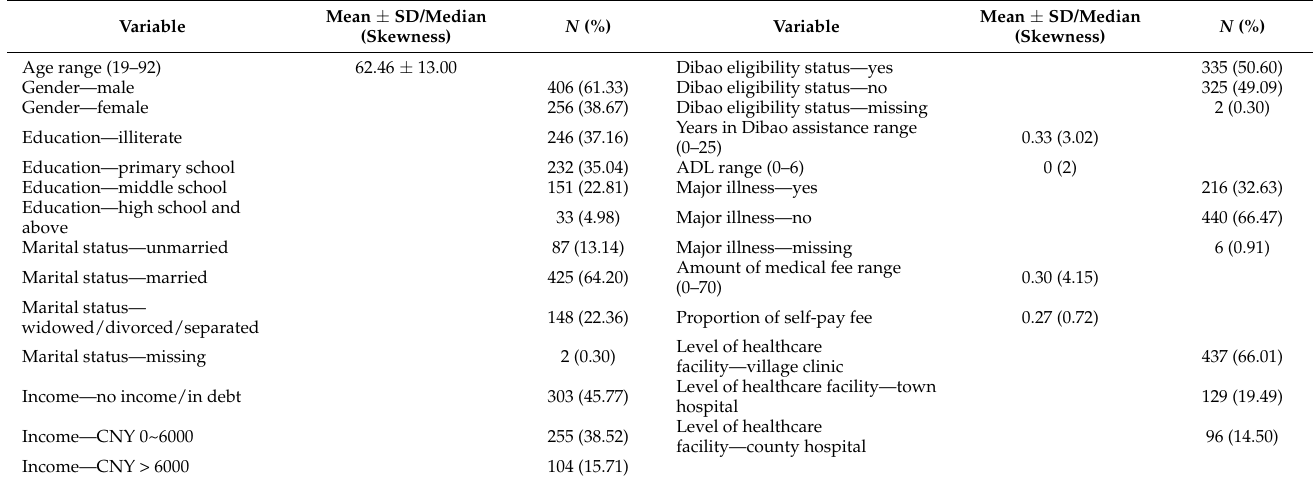
Table 1. Descriptive characteristics of the respondents, N = 662.